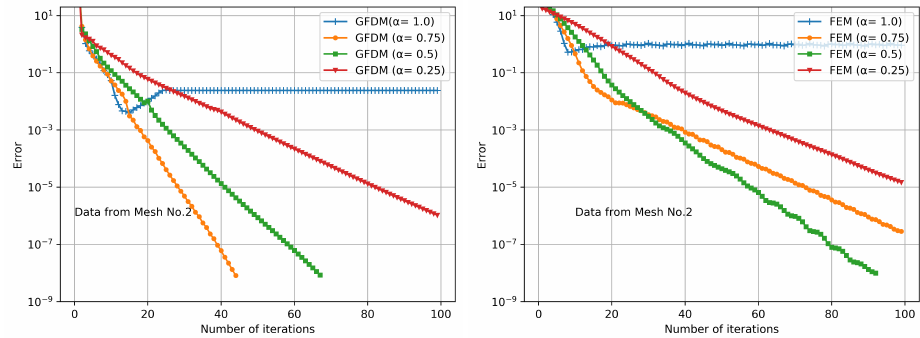
Figure 10. Convergence history on mesh no. 2 (refined mesh).